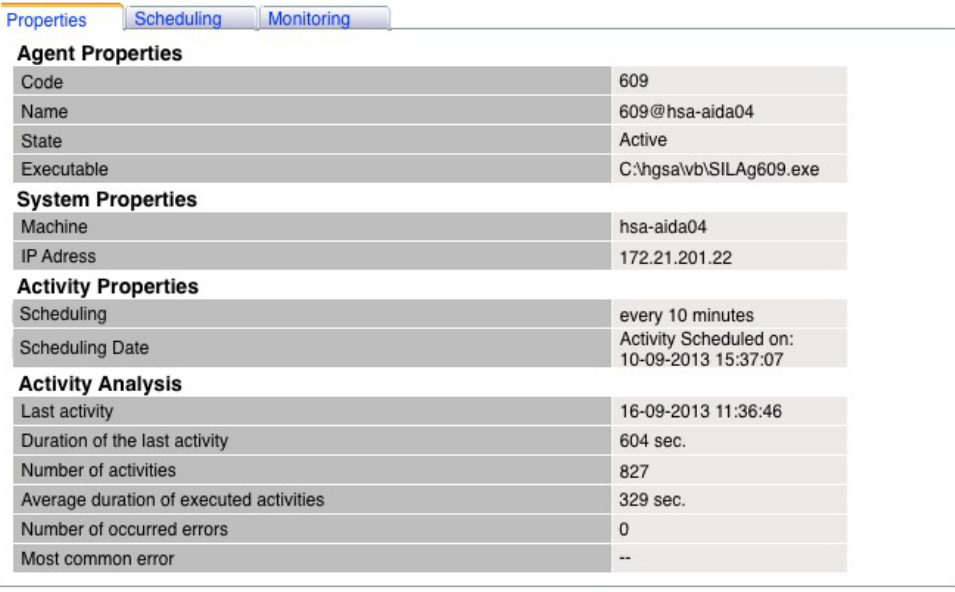
Figure 5. Properties page from Agent